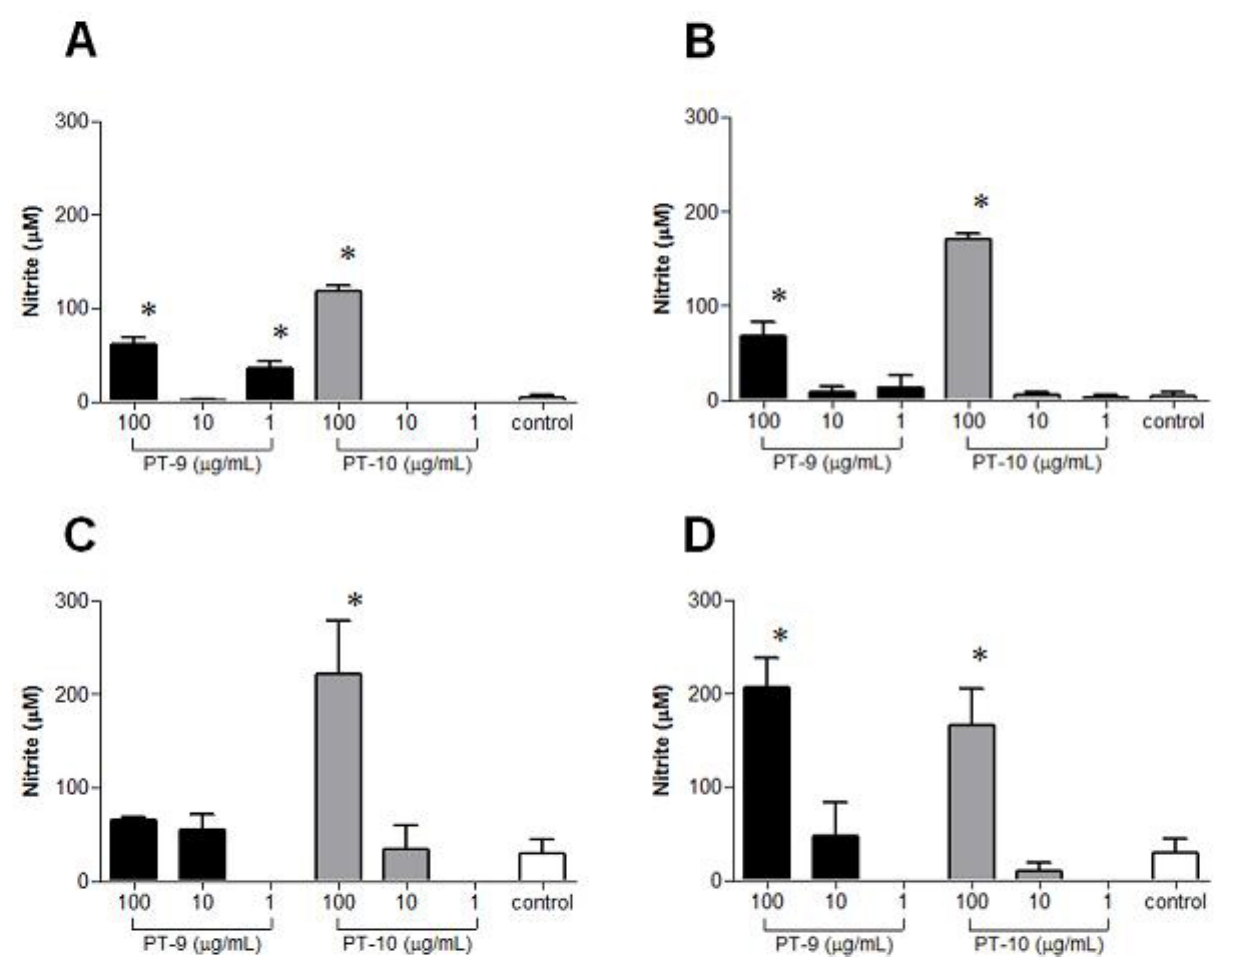
Figure 1. Nitrite production in immune spleen cell cultures from BALB/c mice comparing experimental imidazolidines. Control is culture without stimulus. ( A ) and ( B ): Twenty-four and 48 hours of assay, respectively. At these two experimental times, LPSF/PT-9 and LPSF/PT-10 showed higher values than the control and among themselves. ( C ) Seventy-two hours of assay. LPSF/PT-10 at 100 µg.mL –1 did show statistical difference to control. ( D ) LPSF/PT-9 and LPSF/PT-10 at 100 µg.mL –1 did show statistical difference in relation to control and among themselves at six days of assay. Horizontal bars represent the average of three independent experiments per group. * p <